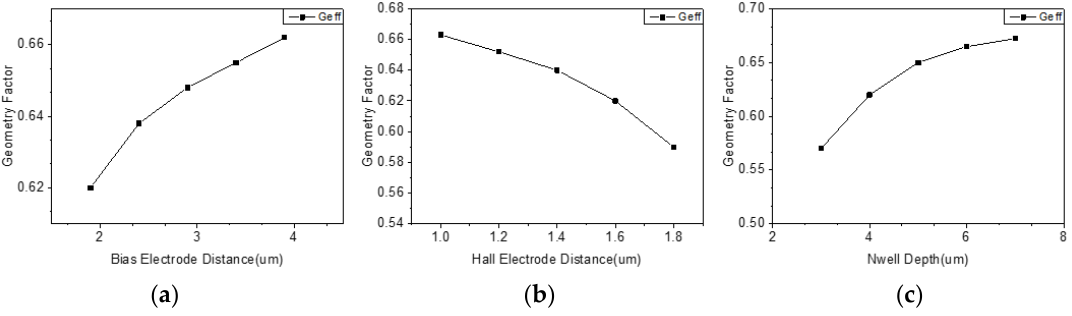
Figure 7. ( a ) Effect of position of bias electrode on device performance; ( b ) effect of position of Hall electrode on device performance; ( c ) effect of N-well depth on device performance.